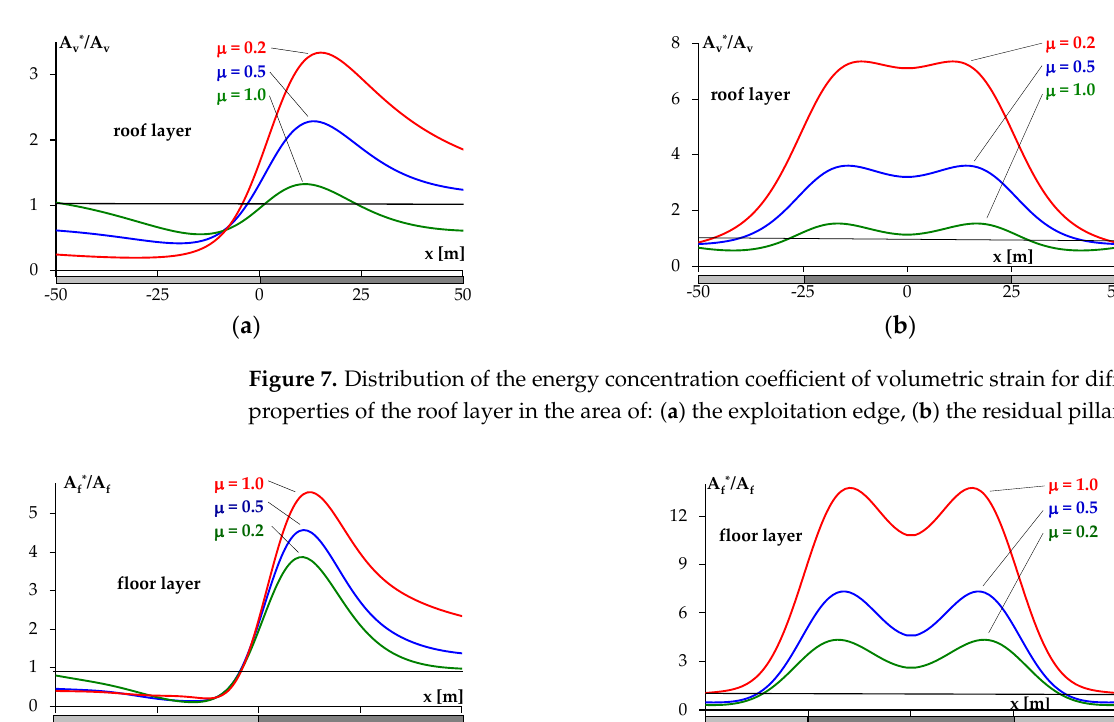
properties of the roof layer in the area of: ( a ) the exploitation edge, ( b ) the residual pillar.